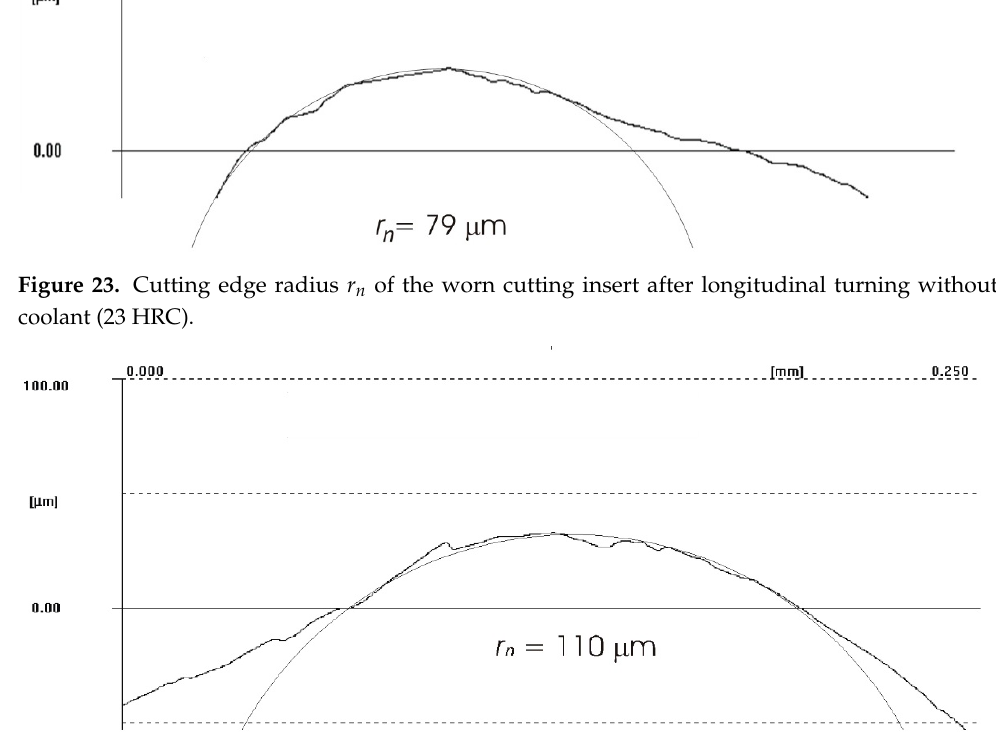
Figure 24. Cutting edge radius r n of the worn cutting insert after longitudinal turning without coolant (36 HRC).